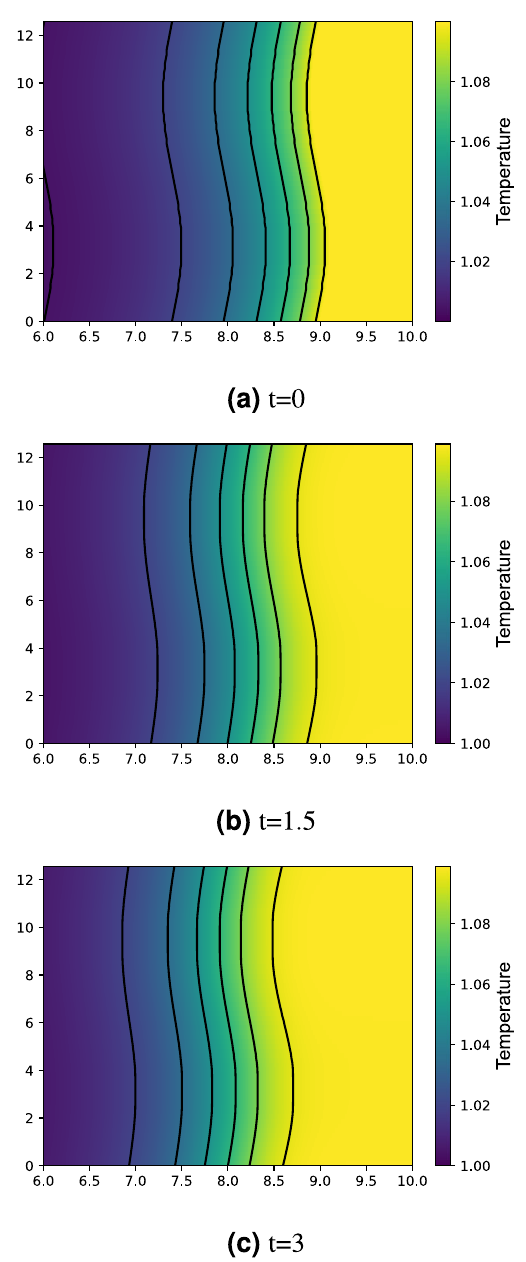
Figure 12. Temperature distribution for le